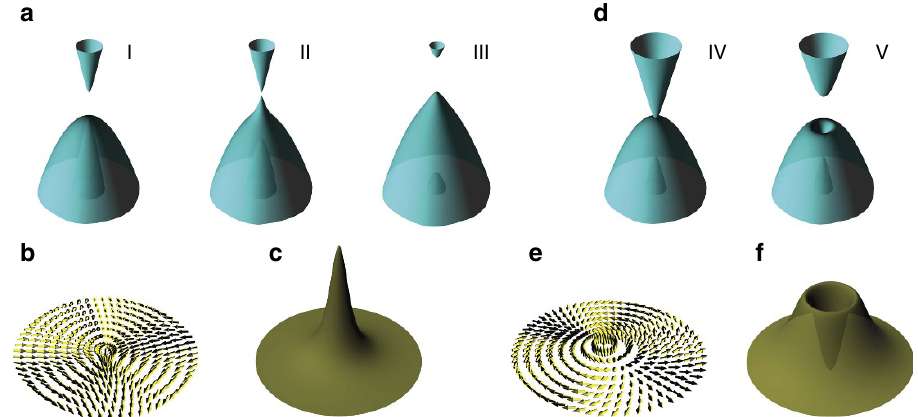
Figure 2 | Band, vortex and Berry curvature around the C point. ( a ) 3D band structure around the G point for bands I–III, illustrating the s–p band inversion process. ( b , c ) Vortex structure of ^ d and Berry curvature around the G point for the effective ( s , p ) two-band model of band III in a . ( d ) 3D band structure around the G point for bands IVand V, illustrating the p – p bandgap-opening process. ( e , f ) Vortex structure of ^ d and Berry curvature around the G point for the effective ( p , p ) two-band model of band V in d